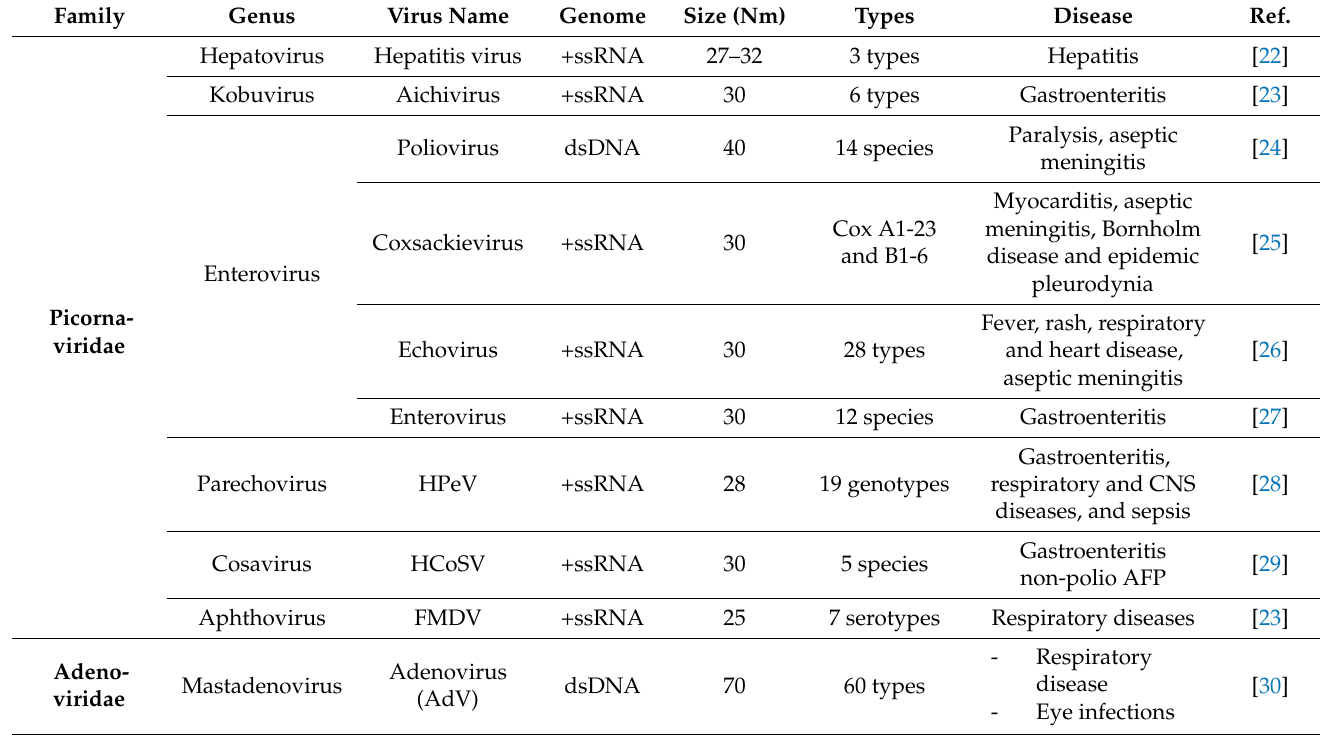
Table 1. Transmissible viruses via